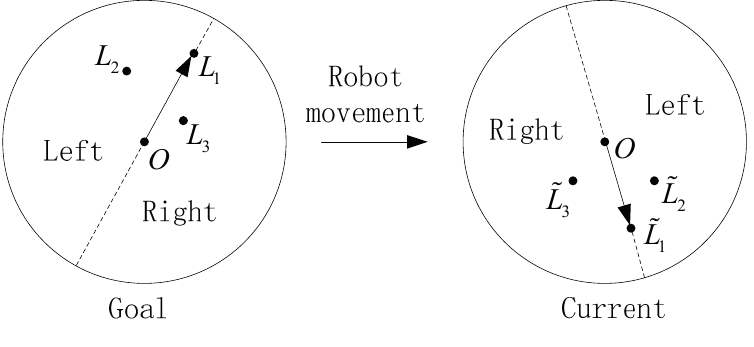
Figure 3. Distribution Constraint